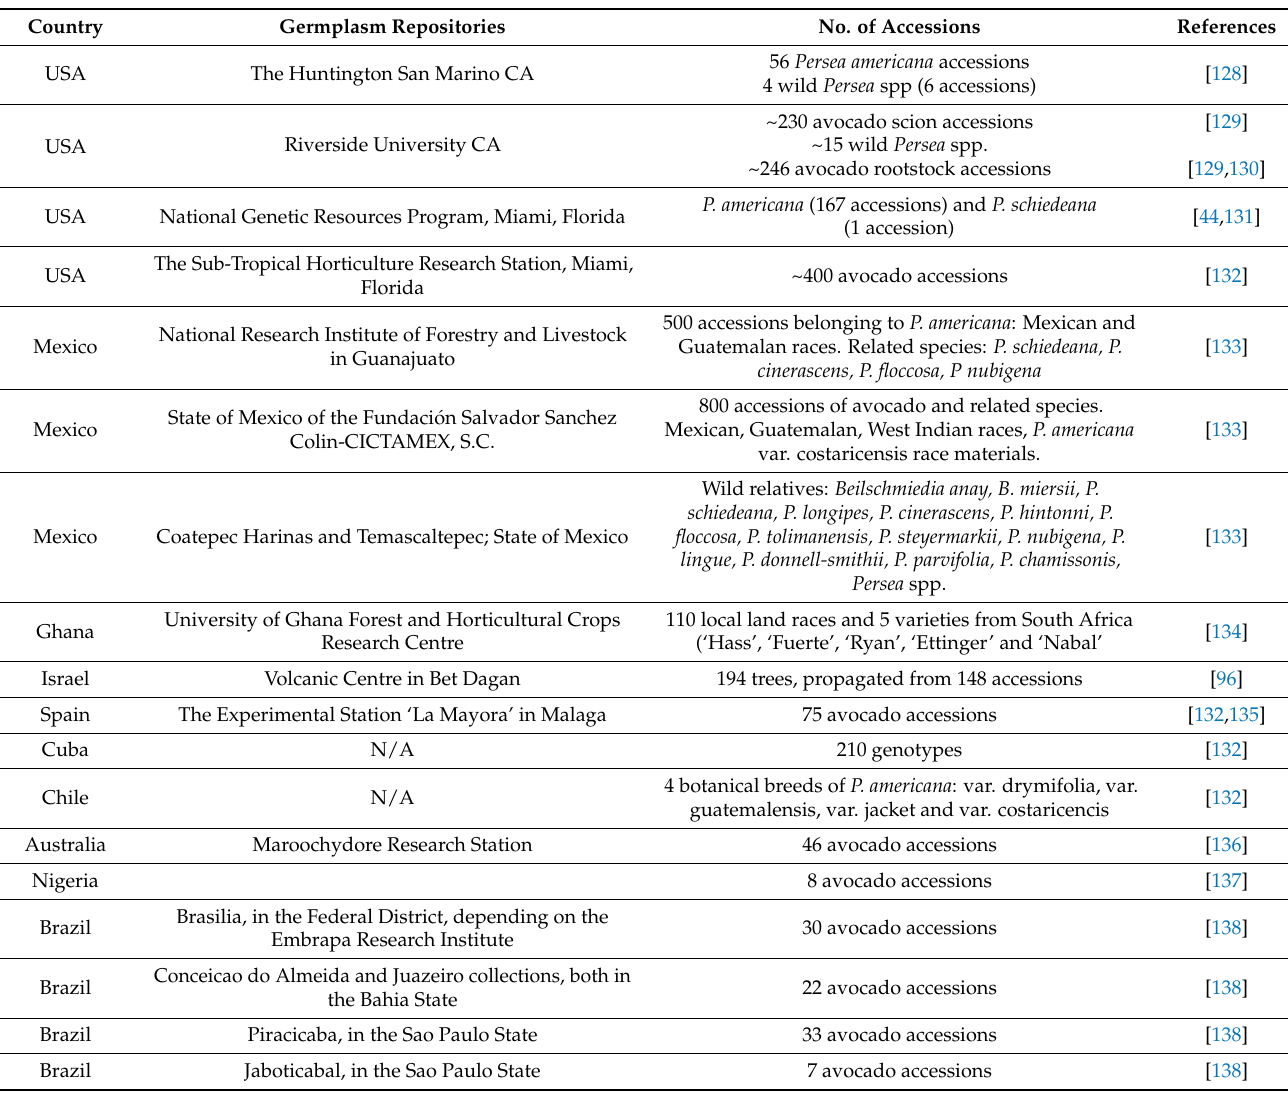
Table 6. Avocado germplasm maintained as field repositories throughout the